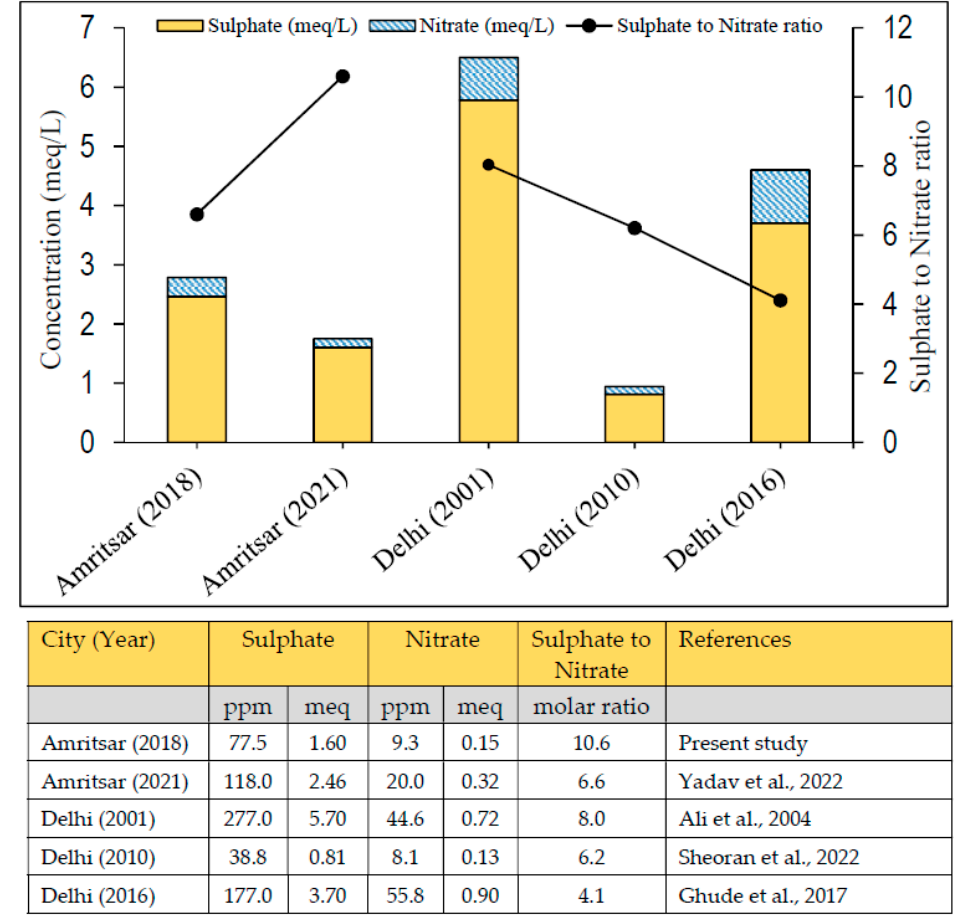
Figure 7. Stacked graph for sulphate and nitrate concentration along with sulphate to nitrate ratio in fog water. References included are [8,23,25,51].